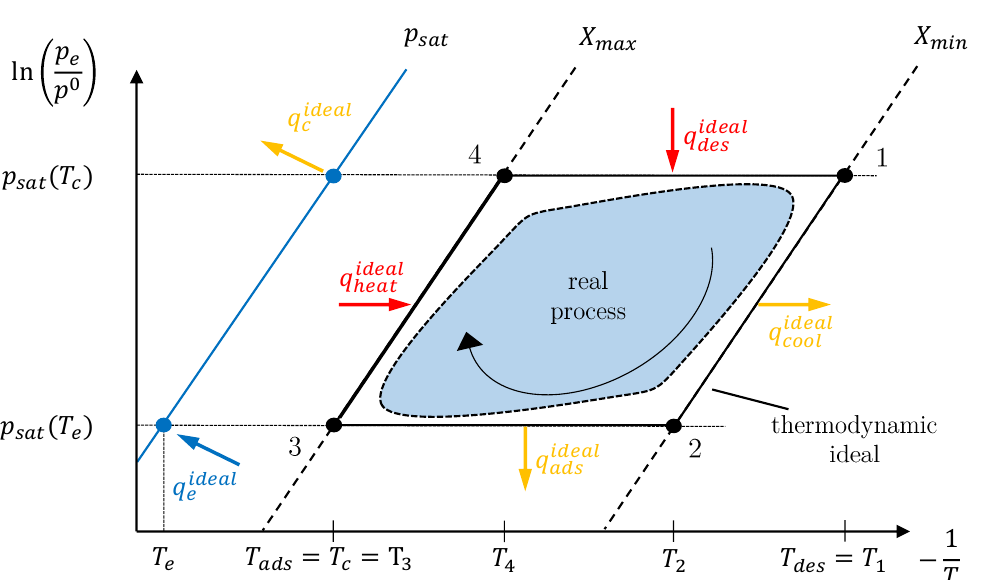
Figure 5. Thermodynamic ideal and real cyclic adsorption cooling process in a Clausius-Clapeyron diagram. The differences arise from kinetic transport